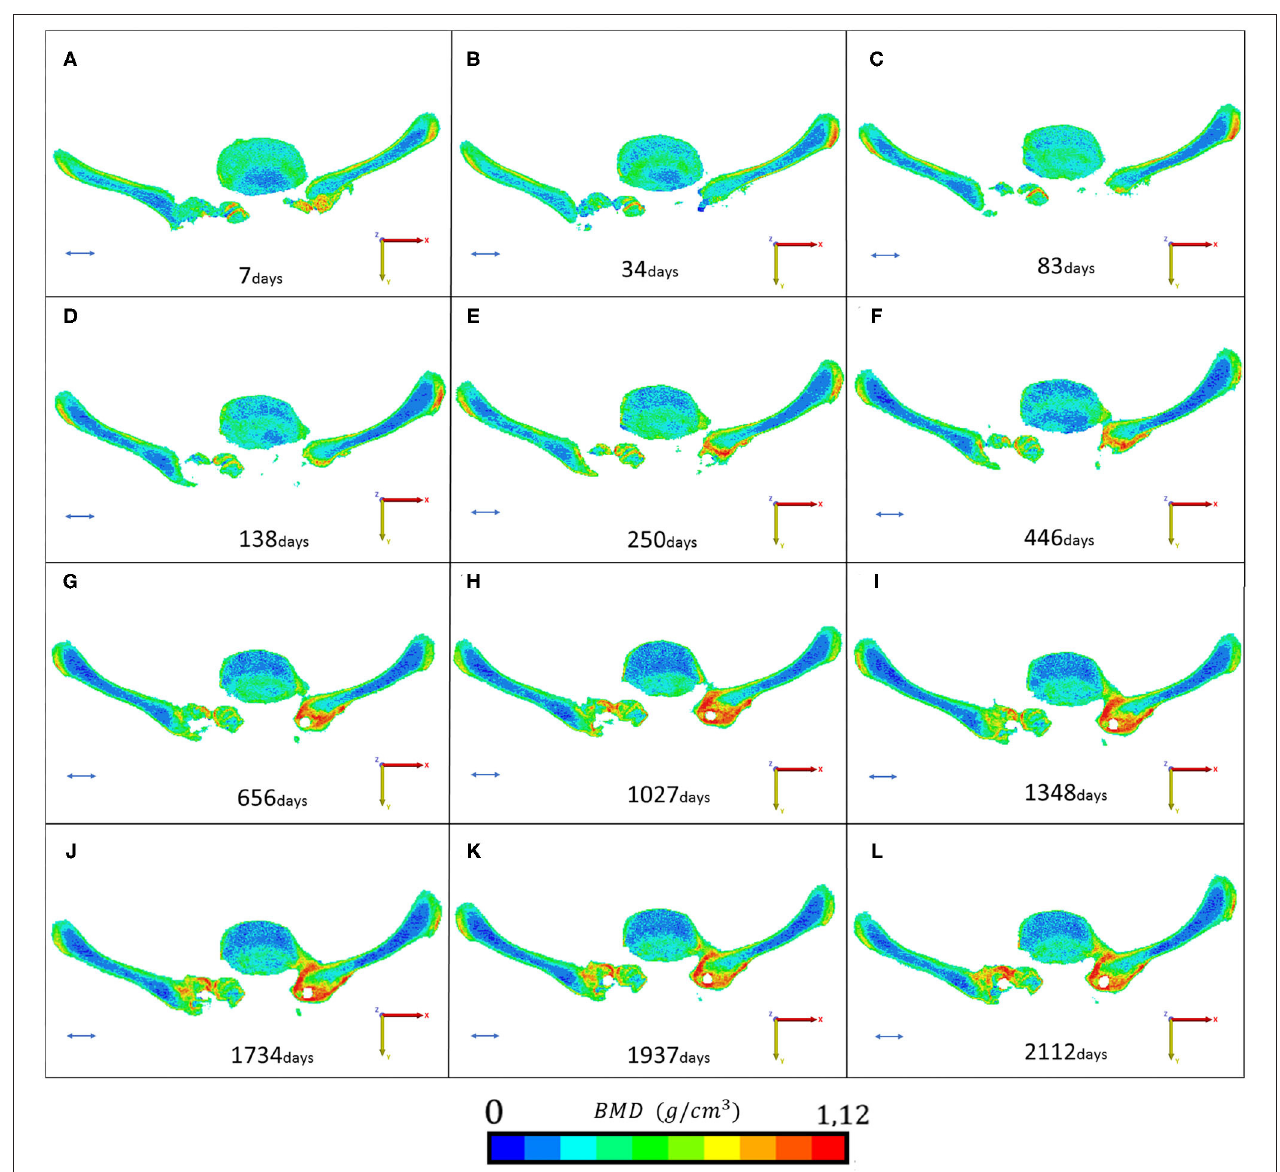
FIGURE 8 | Mapping of the fusion and remodeling process. ( A – L) Represents the region of interest for the 12 postop CT scans (from 7 to 2,112 days). The BMD values are represented in 10 color codes from 0 to 1.12 g/cm 3 on an RGB scale. Red color represents the strongest bone tissue. The provided scale bar’s length is